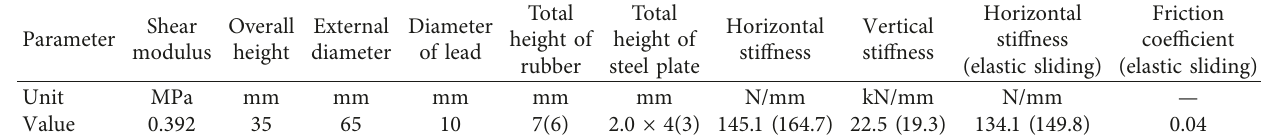
Table 1: Isolation bearing parameters.